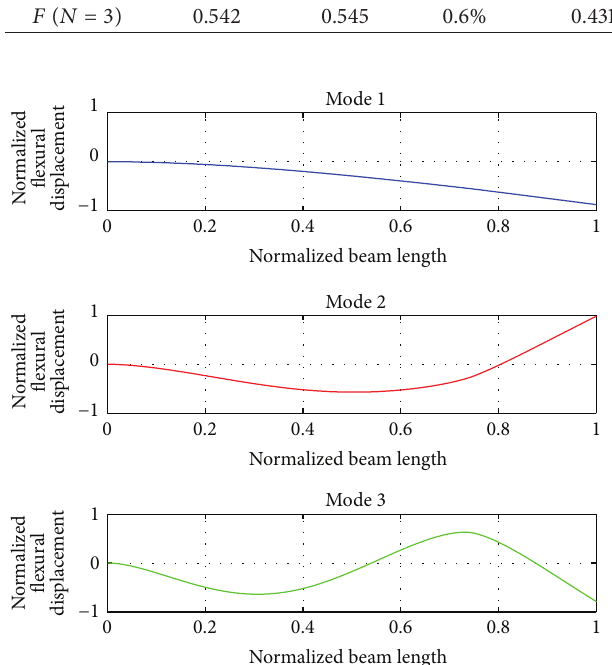
Figure 8: Efficiency curves for full-cover and segmented CLD beams with various values of 𝐻 𝑏 ( 𝐻 𝑏 = 𝐻 𝑐